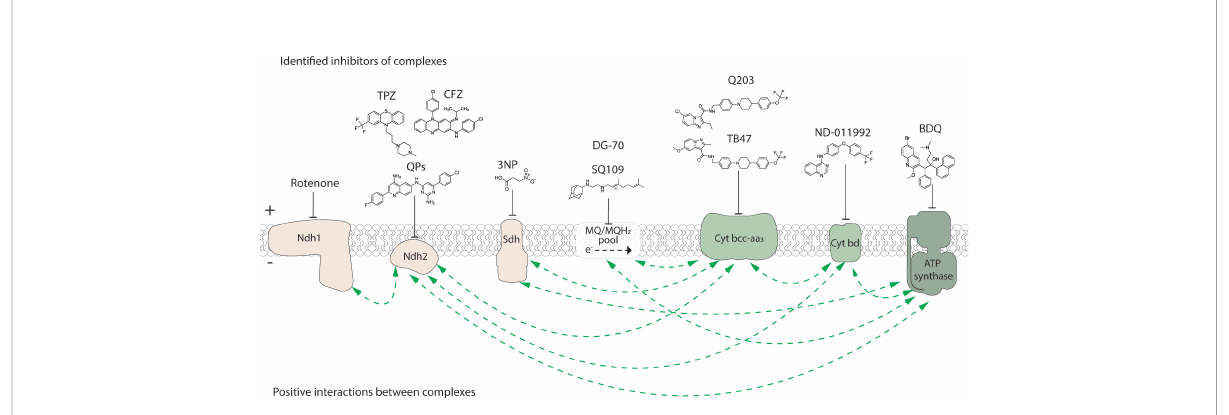
FIGURE 1 Inhibitors of the electron transport chain and ATP synthase of M. tuberculosis. Known inhibitors of respiratory components, example structures and their targets are illustrated with fl athead arrows. Flathead arrow placement does not re fl ect the speci fi c site of inhibition. The dashed arrow in the MQ/MQH2 pool represents the direction of electron fl ow. Electron transport chain complexes and the ATP synthase are coloured as: election donors, beige; electron acceptors, green. Plus (+) and minus (-) symbols represent high and low proton concentration gradient across the cytoplasmic membrane, respectively. QPs, quinolinyl pyrimidines; TPZ, tri fl uoperazine; CFZ, clofazimine; 3NP, 3-nitropropionate; BDQ, bedaquiline. Positive interactions (i.e. synergy or synthetic lethality) between bioenergetic components as reported from either a chemical, genetic or chemical-genetic interaction study and as described in the body of the manuscript are shown with dashed green